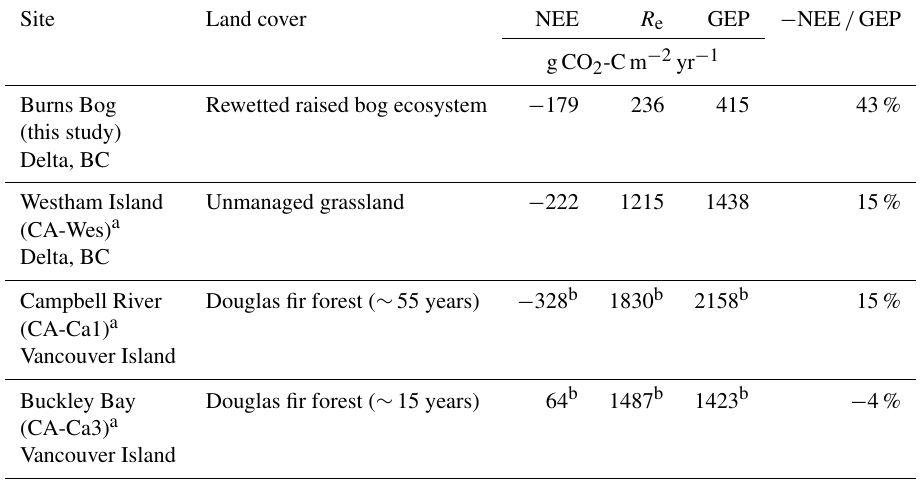
Table 2. Comparison of annual NEE, R e and GEP, over different ecosystems (vegetation covers) in the Vancouver region using EC measure- ments. Sorted by magnitude of − NEE / GEP ratio.